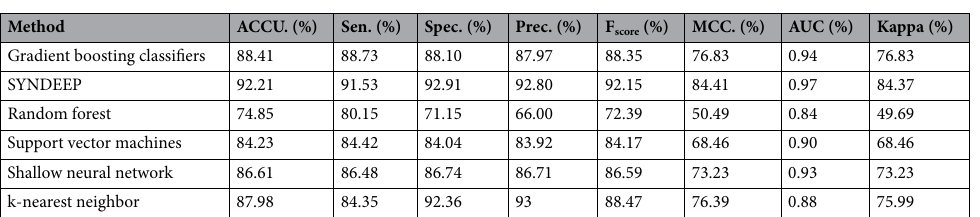
Table 2. The overall results of the different state-of-art methods.